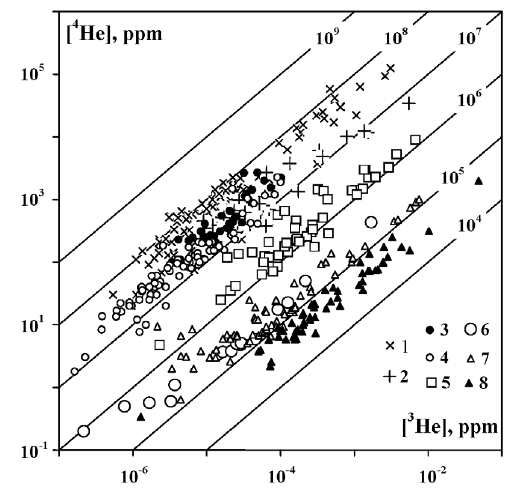
Fig. 2. The relation between the contents of [ 3 He] and [ 4 He] in subsurface fluids freely circulated in rocks (from Mamyrin and Tolstikhin (1984), added). 1 – pre-Ryphean Eastern European Platform, EEP; 2 – the EEP parts re-activated in Ryphean-Paleozoic; 3 – Baikalides (Timan-Pechora province); 4 – Her- cynides (Scythian Plate, SP); 5 – the SP parts re-ac- tivated in Cenozoic; 6 – Hercynian Central French Massif re-activated in Cenozoic; 7 – Italian volcanic areas; 8 – Iceland hot